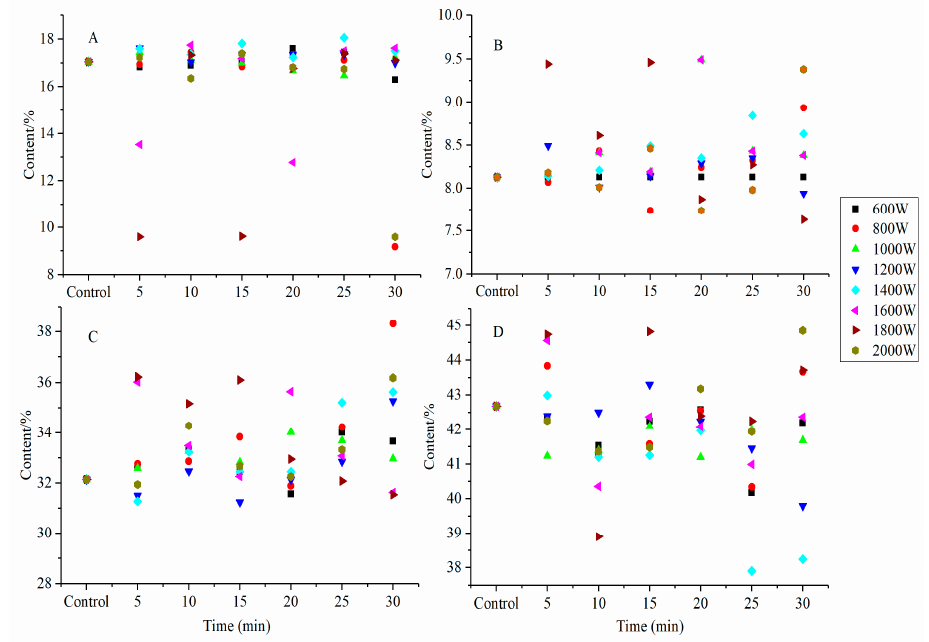
Figure 3. Effects of HIU treatment on secondary structure composition of SPI ( A : α -helix, B : random coil, C : β -sheet, D : β -turn).